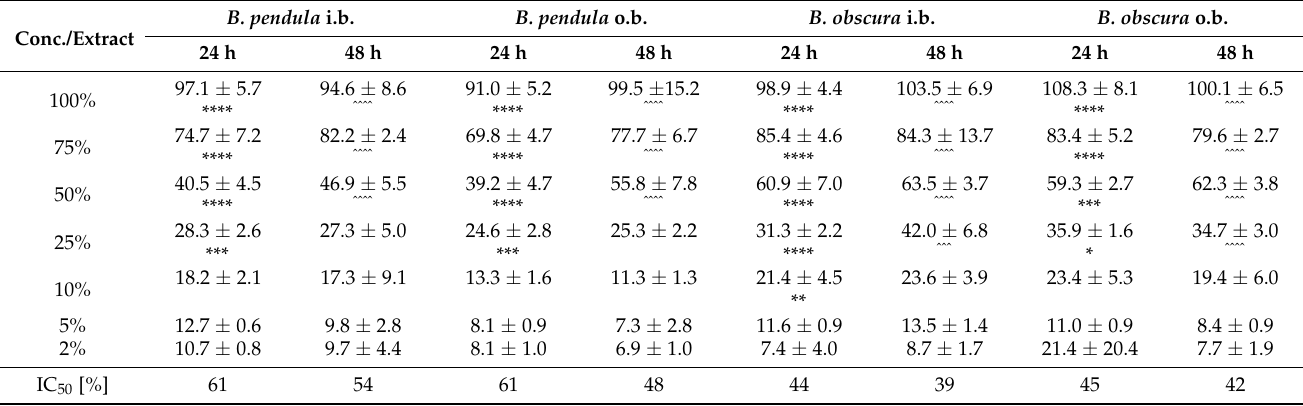
Table 4. Table summarizing percentage of LDH release after the exposition to the tested extracts, acquired by LDH assay after 24 and 48 h incubation. The value of 100% corresponds to the highest readings. Data presented as the means ± SD.